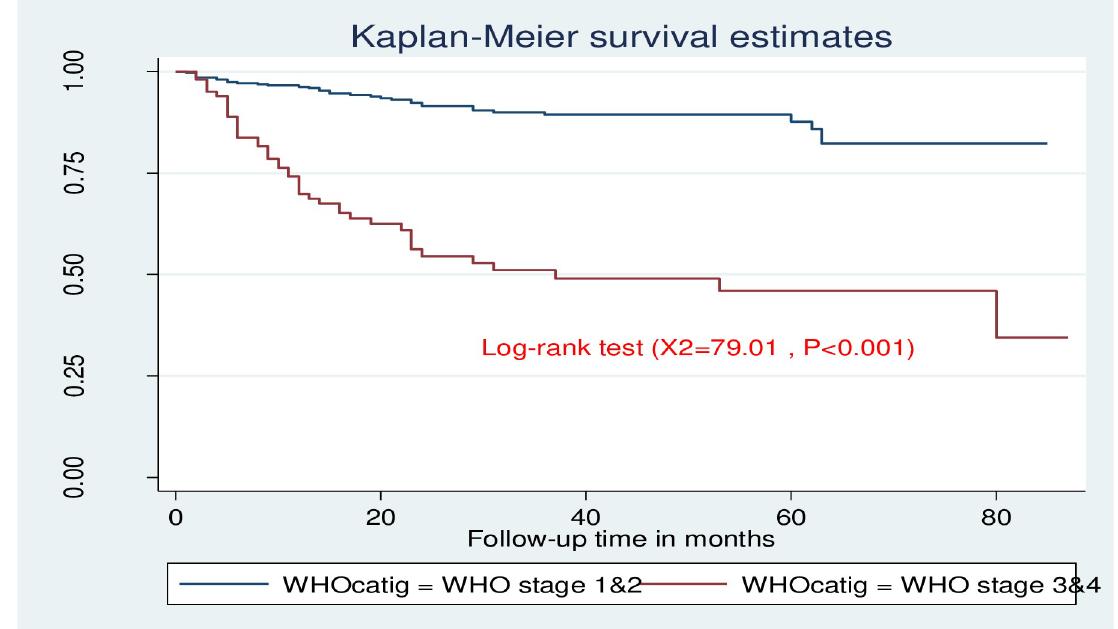
Fig 5. Kaplan-Meier survival estimate for base line WHO clinical stage among adult HIV patients in public health facilities of Arba Minch town, southern Ethiopia, 2020.